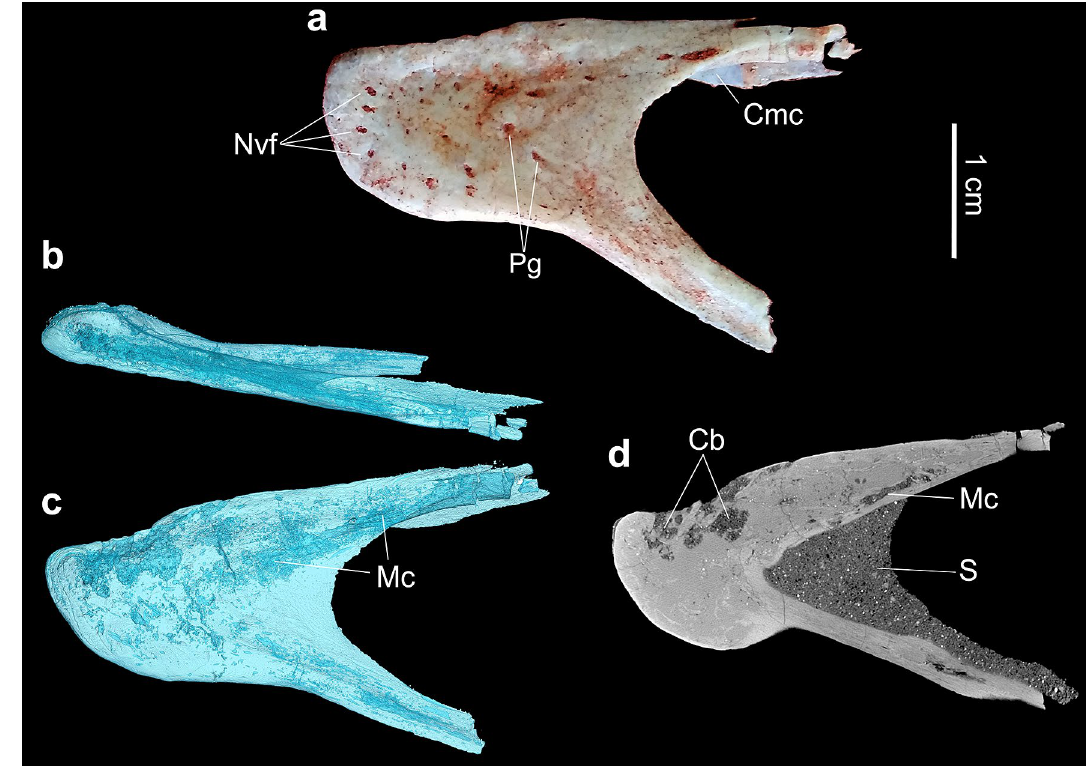
trabecular bone connected with the outer bone surface by foramina, in sagittal view. Abbreviations: Cb, Cavities of trabecular bone; Cmc, Caudal open of Meckelian canal; Mc, Meckelian canal; Nvf, neurovascular foramina; Pg, Pits and grooves; S,